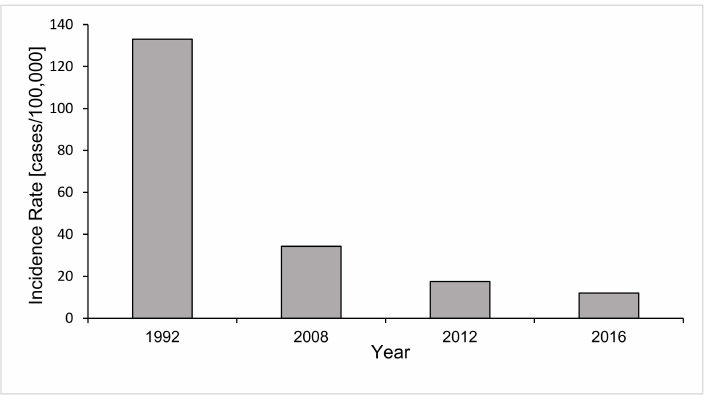
Figure 2. Annual candidemia incidence rates in infants aged ≤ 1 year described from surveillance at a metropolitan site in Georgia in 1992, 2008, 2012 and 2016 [6,44,46]. Candidemia incidence in this age demographic shows a declining trend, with incidence decreasing markedly from 133.0 to 12.0 cases per 100,000 population in 1992 and 2016,